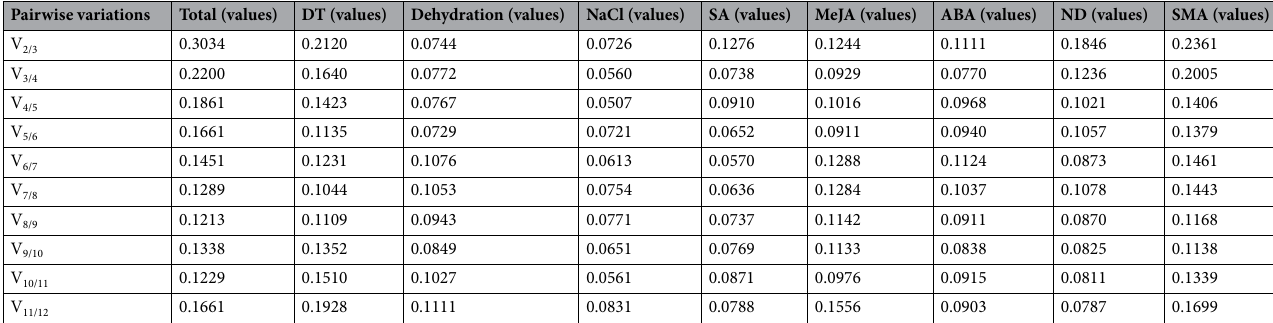
Table 3. Pairwise variation by geNorm determine the optimal number of reference genes.